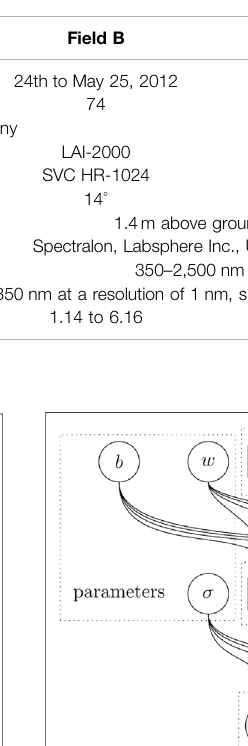
TABLE 1 | Parameters of the dataset and the collection procedures.